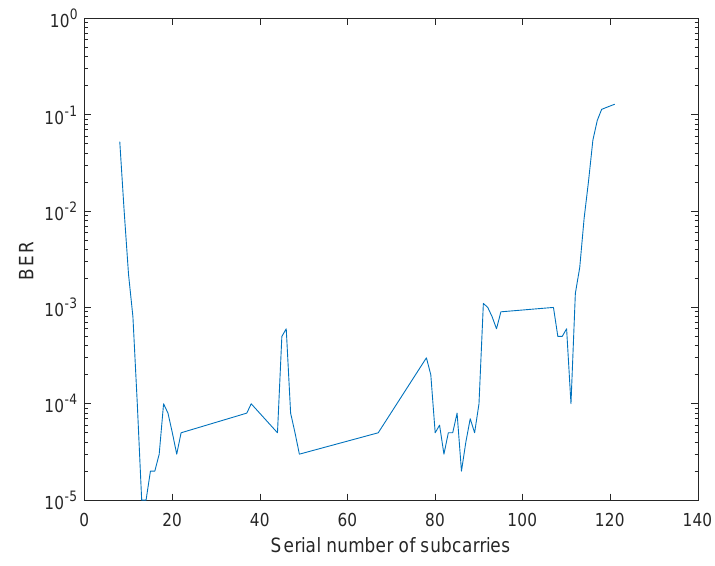
Figure 8. BER of data subcarriers of